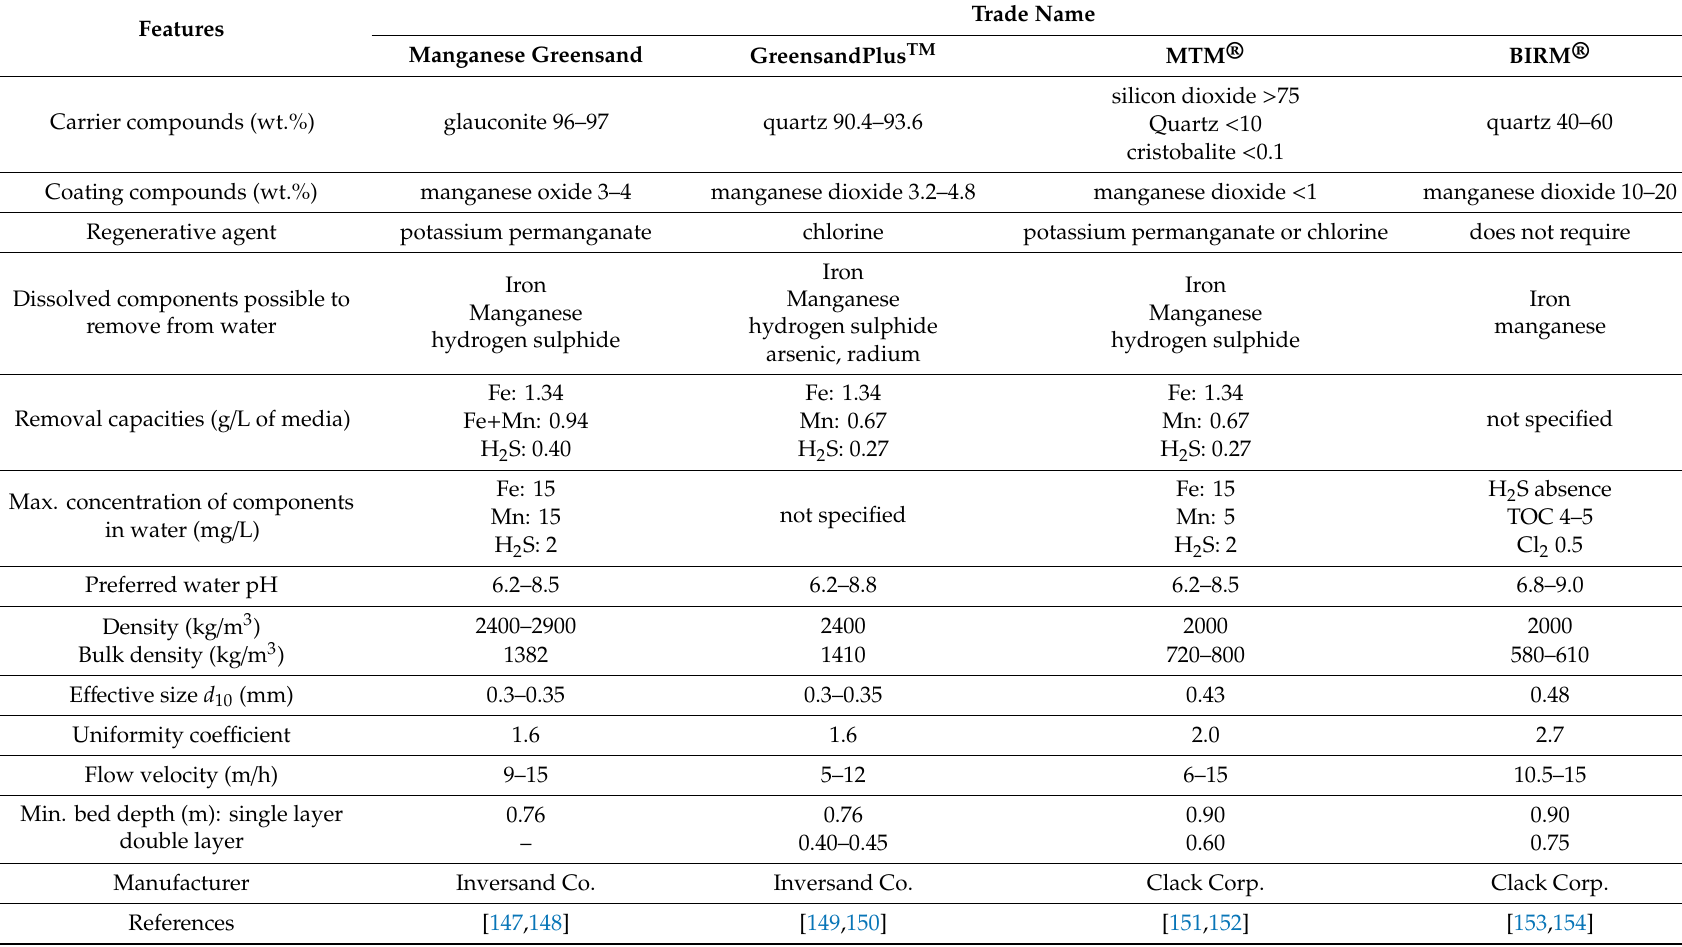
Table 4. Features of commercial MnO x coated filter media. Adapted from